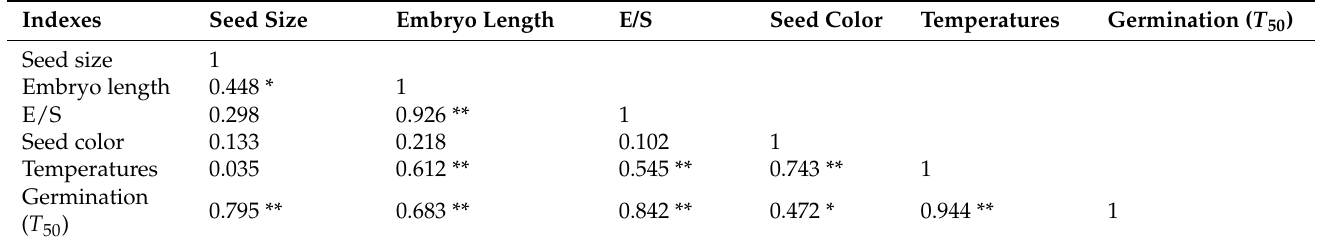
Table 4. Correlations between temperatures and seed morphological indexes on germination.